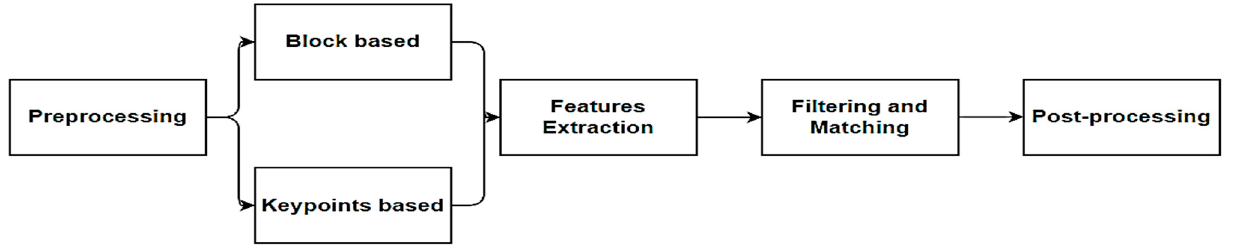
Figure 2. Copy/move detection. Figure 2. Copy/move